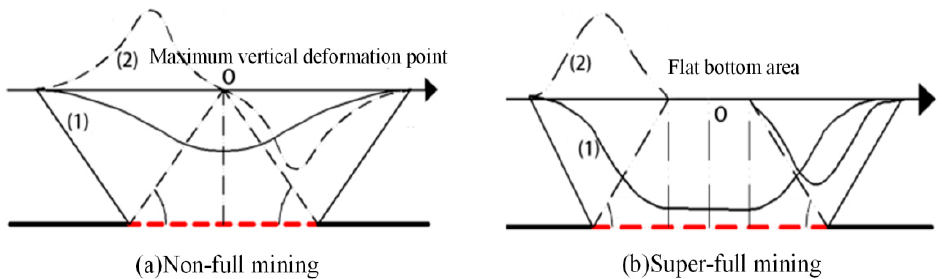
Figure 1. Surface movement curve of the main section of near-horizontal seam mining: (1) the curves of the subsidence and (2) the curves of the horizontal displacement.